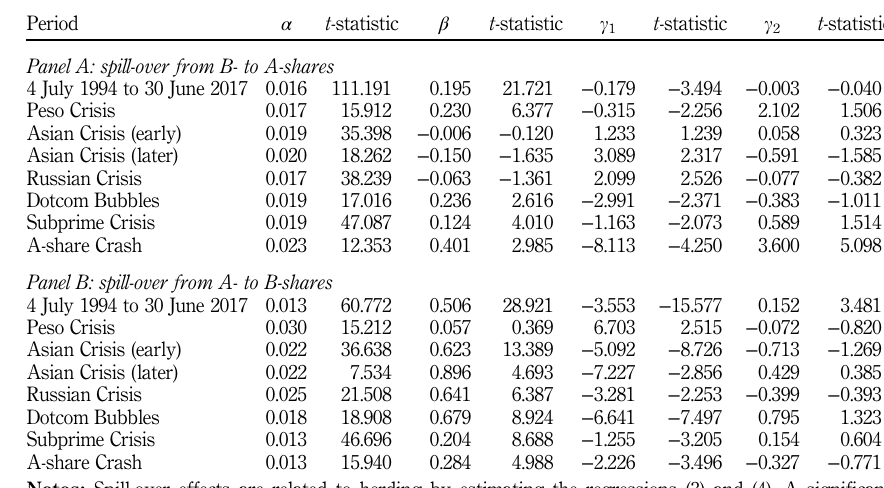
Table III. Spill-over effects related to